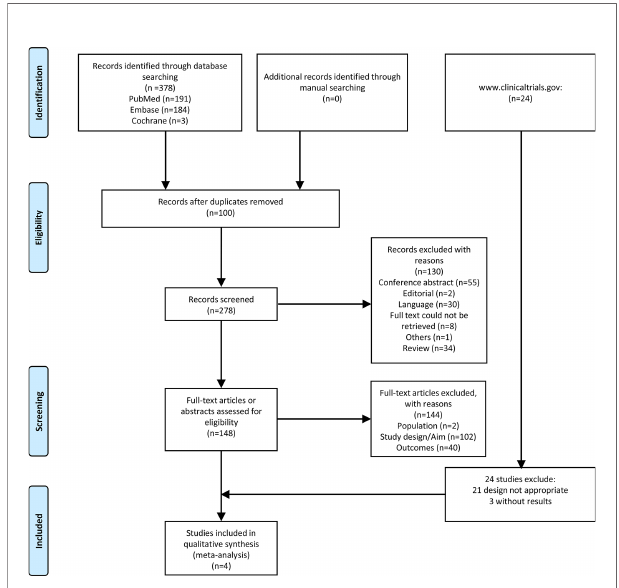
FIGURE 1 | Flow diagram of the study selection process.